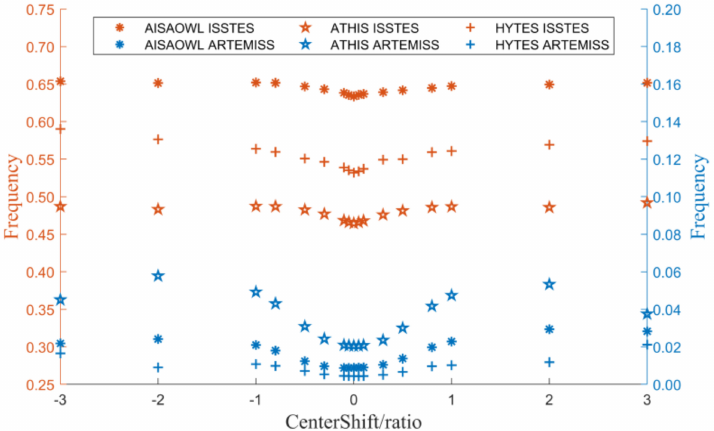
Figure 9. The frequency of inversion failure varying with the center wavelength shift ratio. The X axis is the center wavelength shift ratio, the left and right Y axis scale the results of ISSTES and ARTEMISS